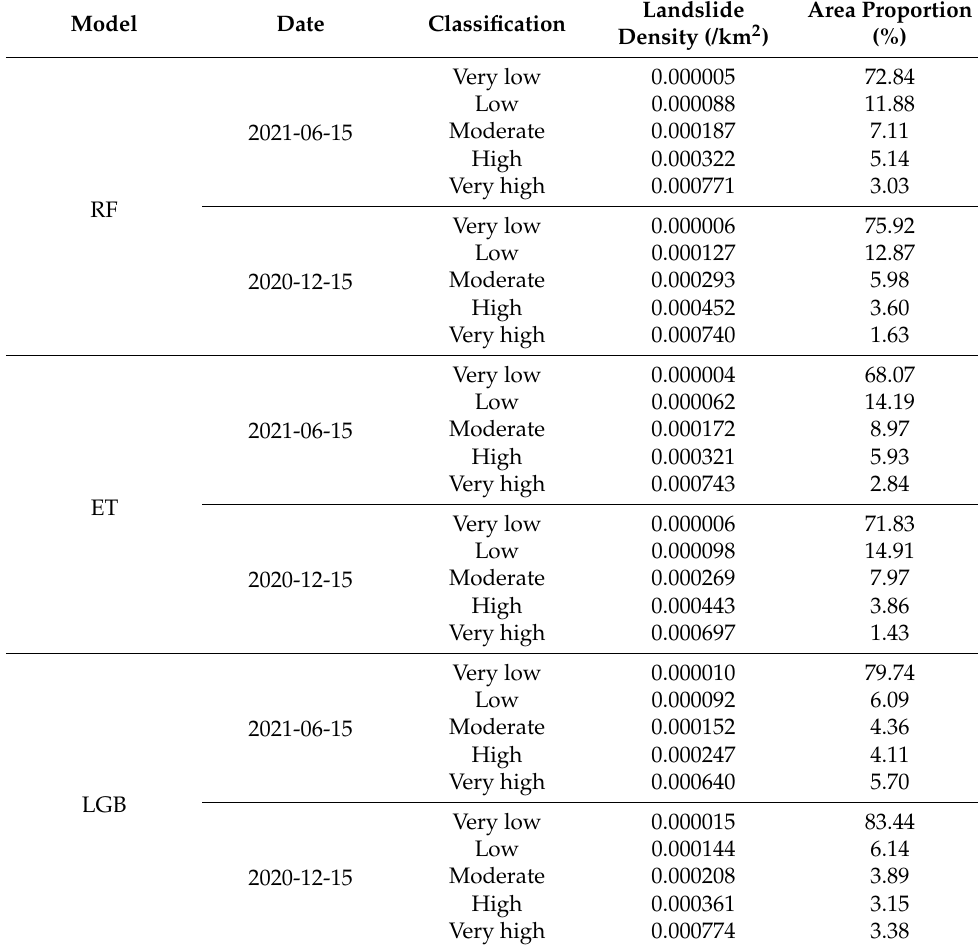
Table 3. Sufficiency analysis of the dynamic LSM